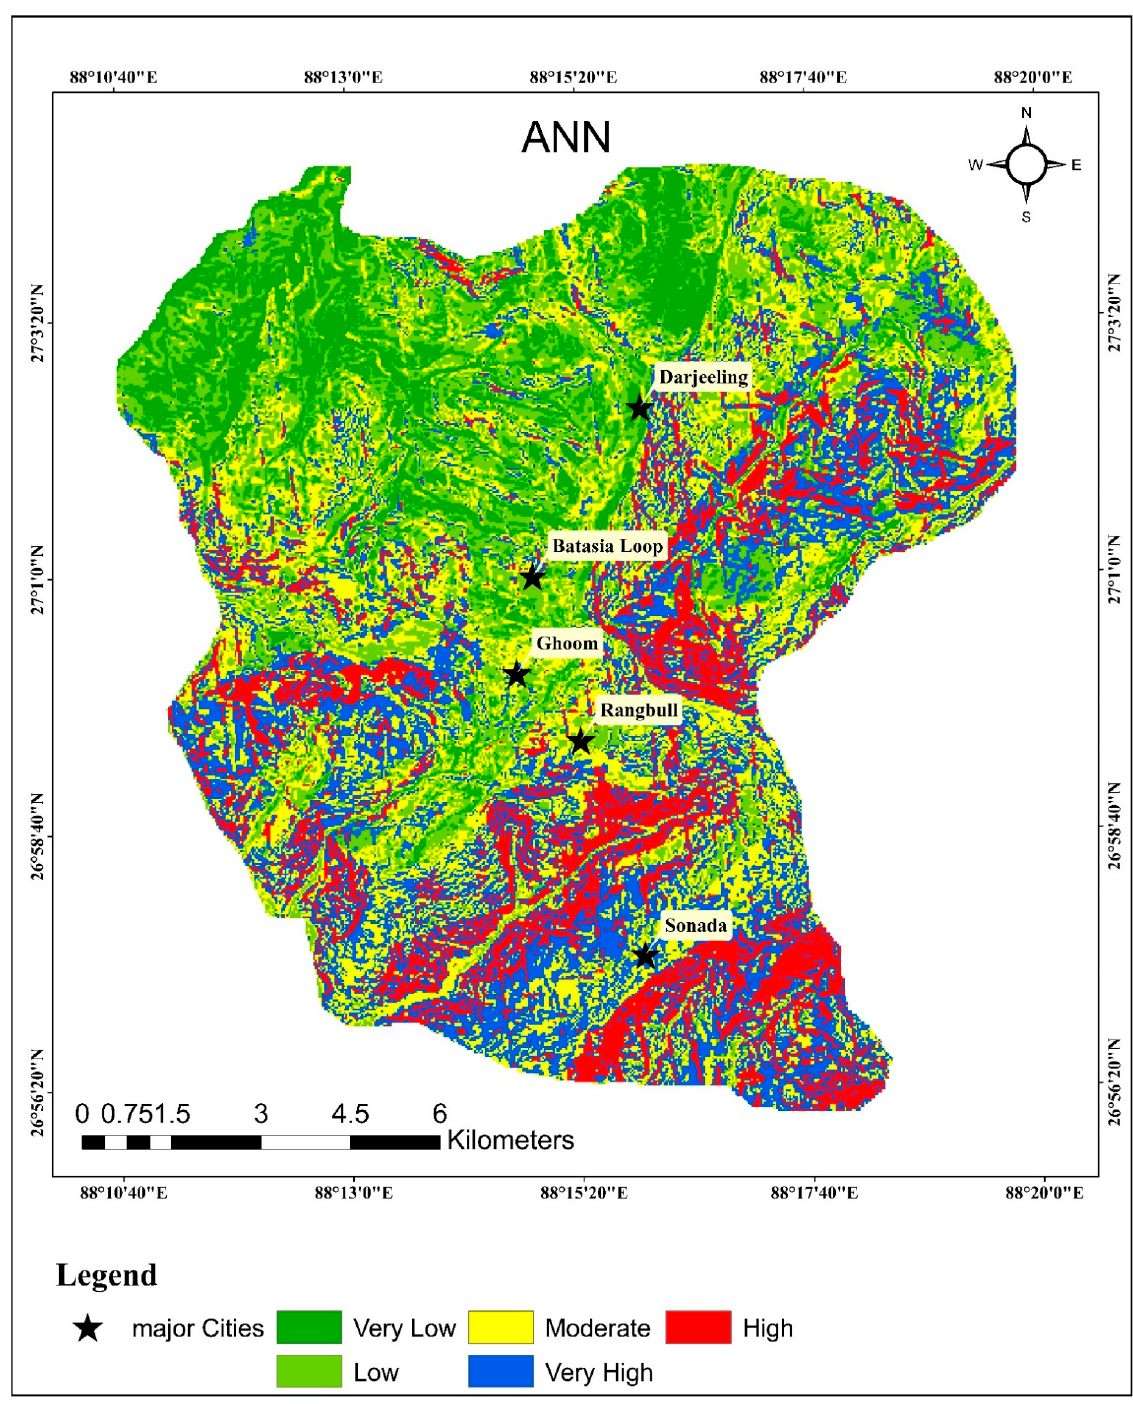
Figure 9. Landslide susceptibility map using ANN model.